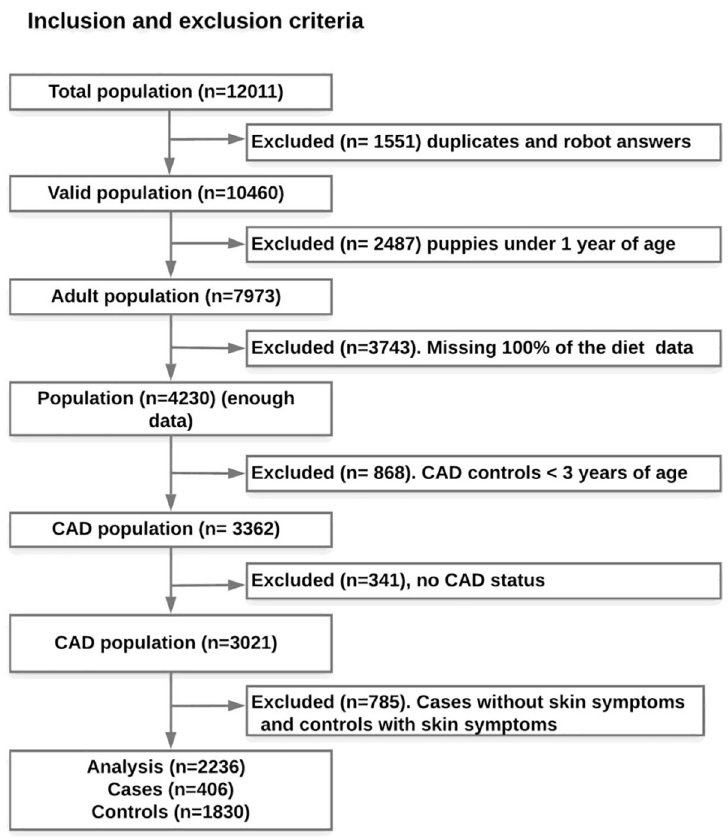
Fig 2. Flow chart of the study population. The study population was extracted from the DogRisk food frequency questionnaire population in the period between 2009 and 2018.